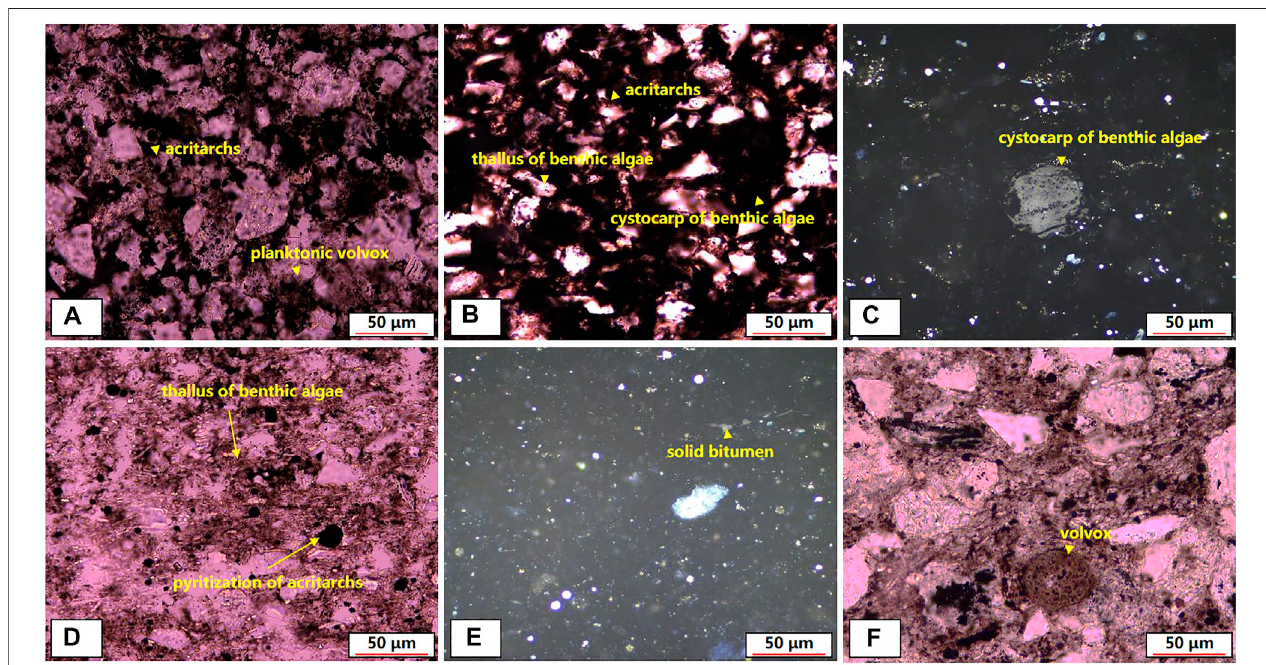
FIGURE 5 | Organic maceral characteristics of the Early Cambrian black strata, Qiongzhusi Fm, W-207 Well, NW Sichuan Basin. (A – D) relative abundant benthic algae, acritarchs (E) Numerous bitumen, and (F) abundant volvox.